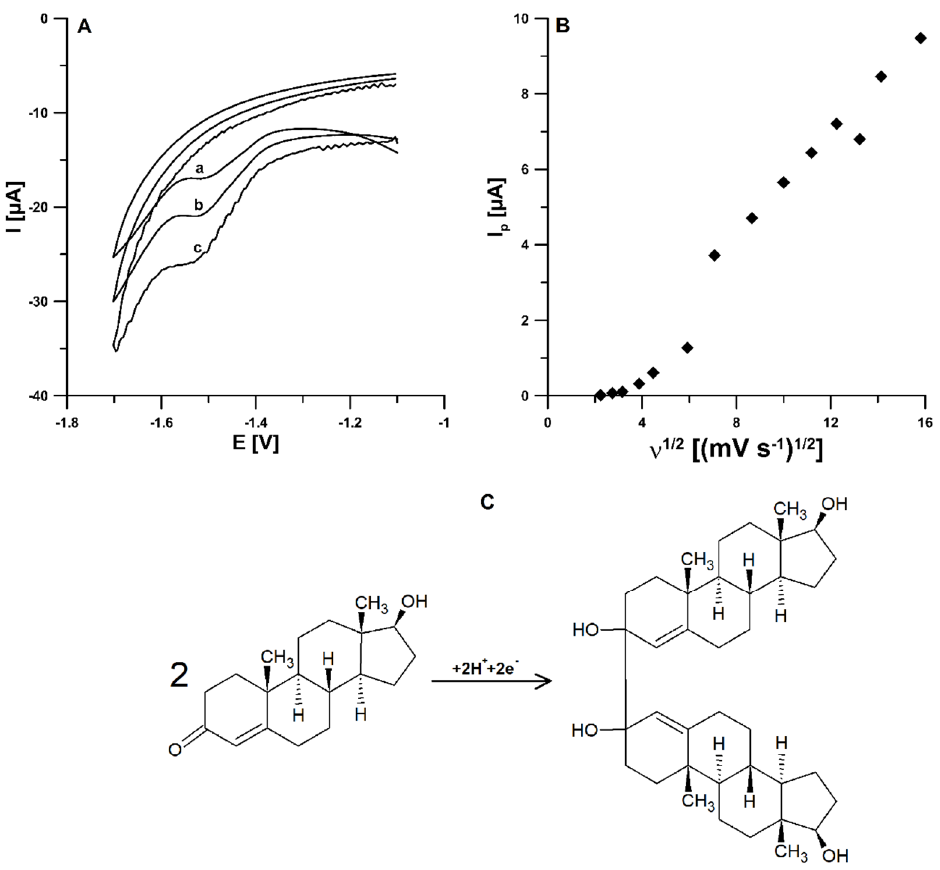
Figure 5. ( A ) CVs obtained at the pSPCE/PbNPs in the 0.075 mol L − 1 acetate buffer of pH 4.6 ± 0.1 containing 7.5 × 10 − 5 mol L − 1 Pb(NO 3 ) 2 and 5.0 × 10 − 6 mol L − 1 TST ( υ of 35, 50, 75 mV s − 1 ). ( B ) The dependence between TST signal (I p ) and the square root of the scan rate ( υ ) ( υ in the range of 5–250 mV s − 1 ). ( C ) The possible TST reduction mechanism.